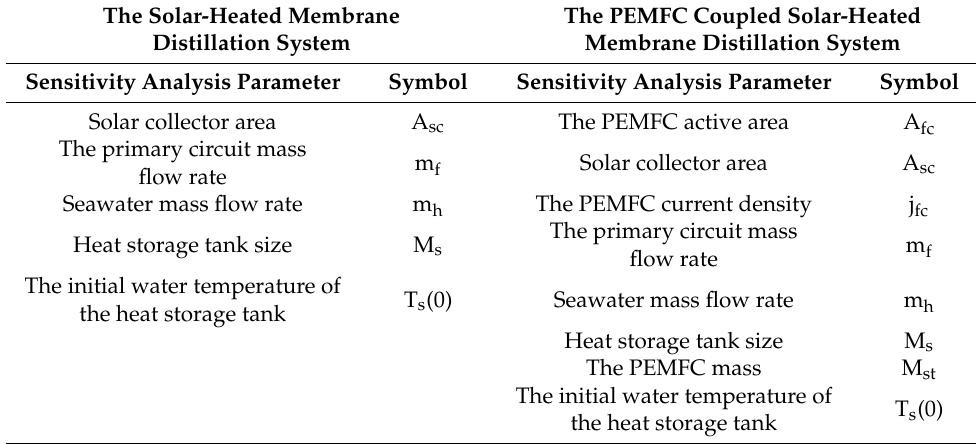
Table 5. Sensitivity analysis parameter of two systems.